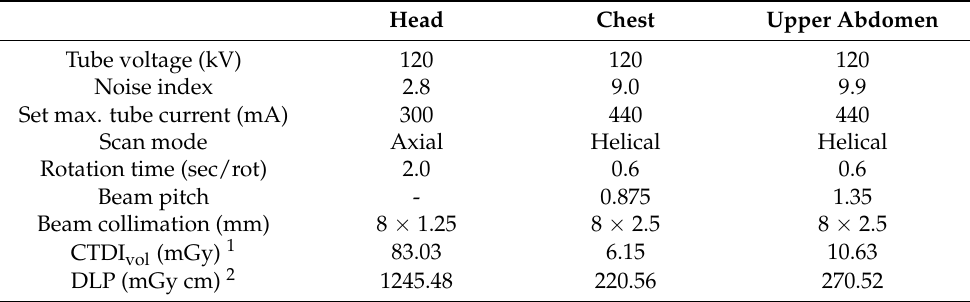
Table 1. Scan parameter and dose information obtained from the CT scanner console. Head Chest Upper